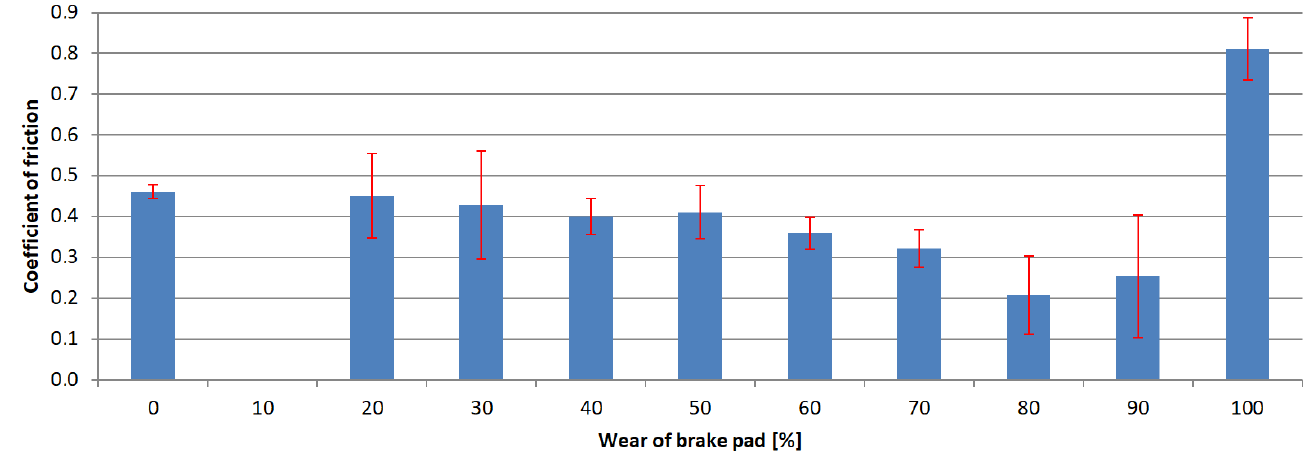
Figure 7. Coefficient of friction values of samples obtained from 2nd brake pad group.